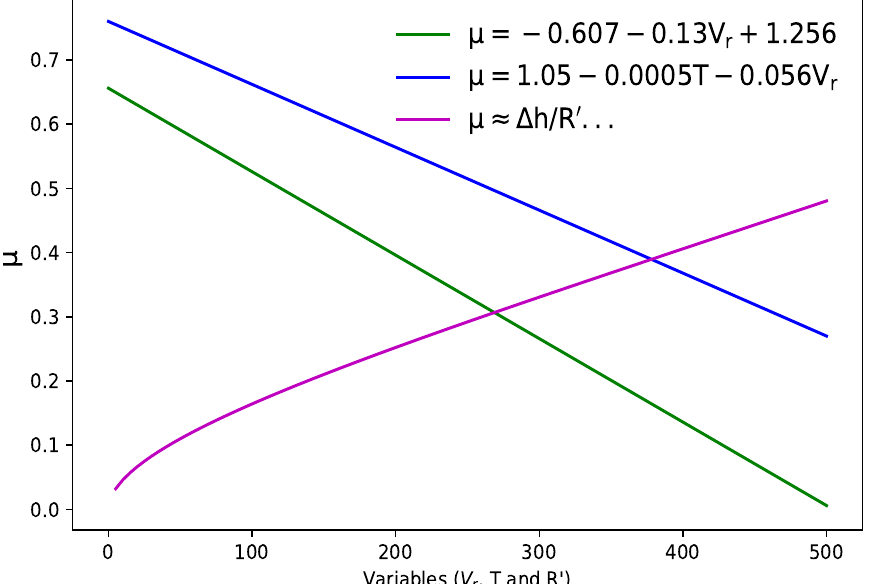
Figure 8. The coefficient of friction as a function of the temperature, reduction and the rolling die surface velocity.